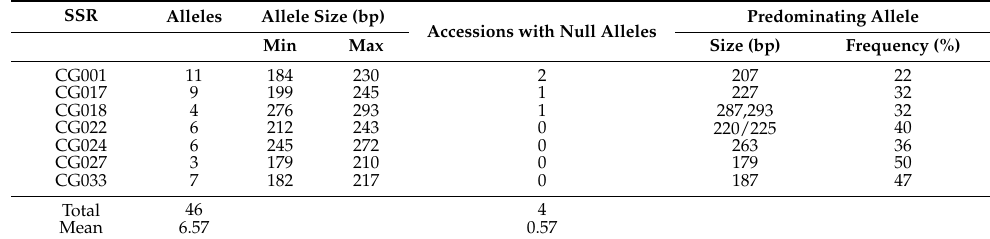
Table 4. Allelic variation of the microsatellite markers used for genotyping 18 spider plant accessions. SSR Alleles